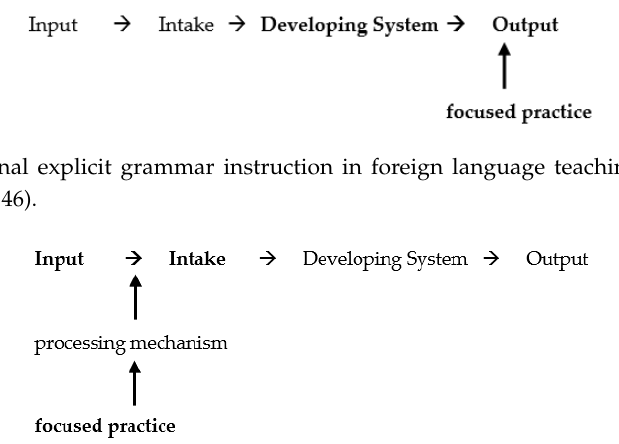
Figure 4. Processing instruction in foreign language teaching (VanPatten and Cadierno 1993b, p. 46).